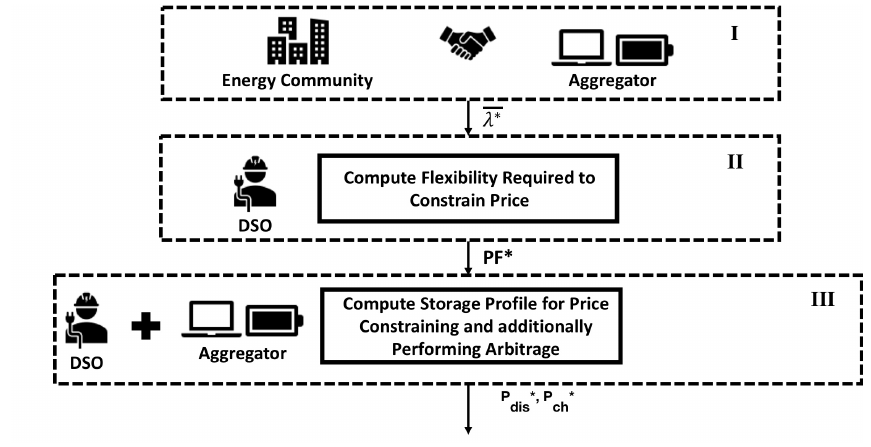
Figure 1. Schematics of the information flow between